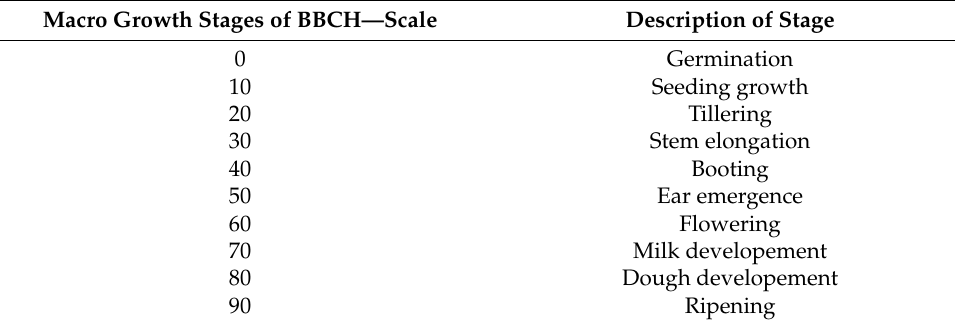
Table 2. Macro growth stages of winter wheat